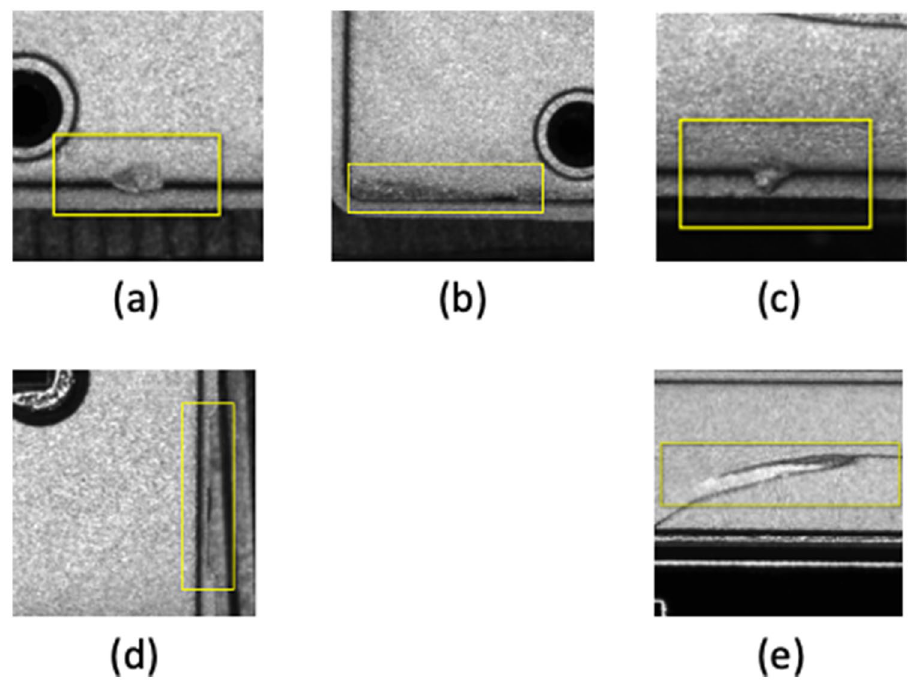
Figure 1. Common chip surface defects, ( a ) large area missing, ( b ) small area missing, ( c ) excess solder, ( d ) pits, ( e ) breach. ( c ) excess solder characterized by a bulge at the margin of chip, with a very small thickness of about 0.1 mm. ( d ) pit defect characterized by an irregular depression. ( e ) breach defect characterized by a width of 0.3mm and a length of 1mm.